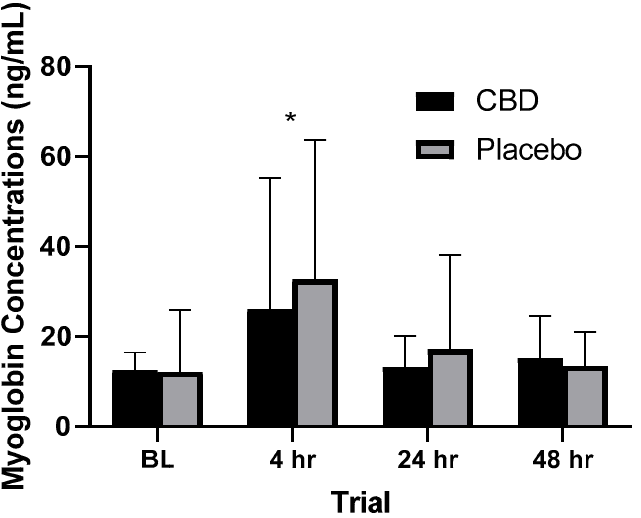
Figure 4. Myoglobin values at various time points. * Statistically significant difference ( p = 0.002) observed from baseline measurement. BL = 2 h prior to muscle damaging protocol, 4 hr = 4 h post- muscle damaging protocol, 24 hr = 24 h post-muscle damaging protocol, 48 hr = 48 h post-muscle damaging protocol. ( n = 24).